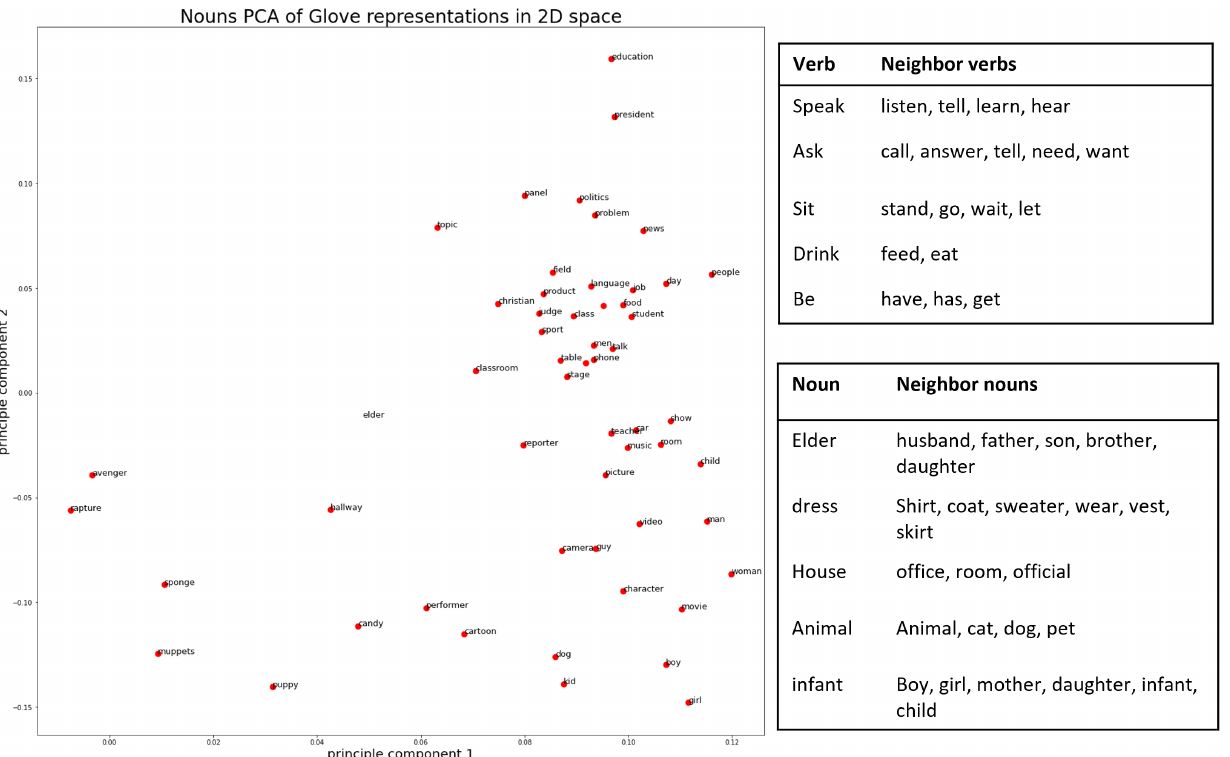
Figure 3. Left : 2D plot of the first two principal components of a subset of nouns’ GloVe represen- tations of the MSR-VTT dataset. Right Top : samples of verbs and their respective neighbor verbs measured by the Euclidean distance between their GloVe vectors. Right Bottom : samples of nouns and their respective neighbor nouns measured by the Euclidean distance between their GloVe vectors.